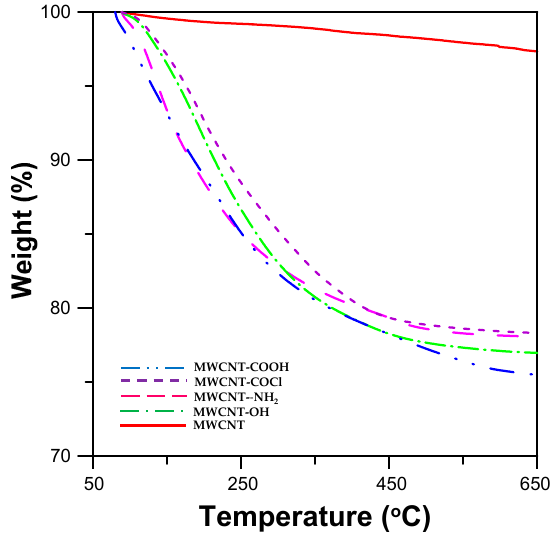
Figure 1. Thermal degradation of surface-functionalized MWCNTs.